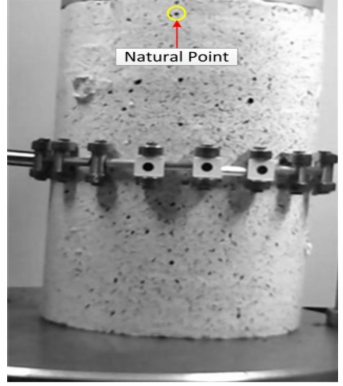
Figure 7. Natural point instead of target G 1 .